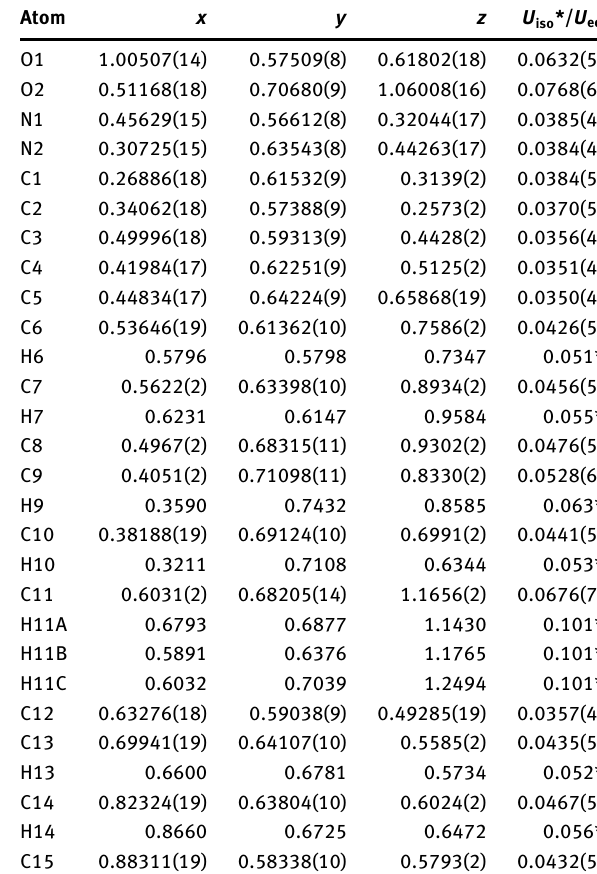
Table 2: Fractional atomic coordinates and isotropic or equivalent isotropic displacement parameters (Å 2